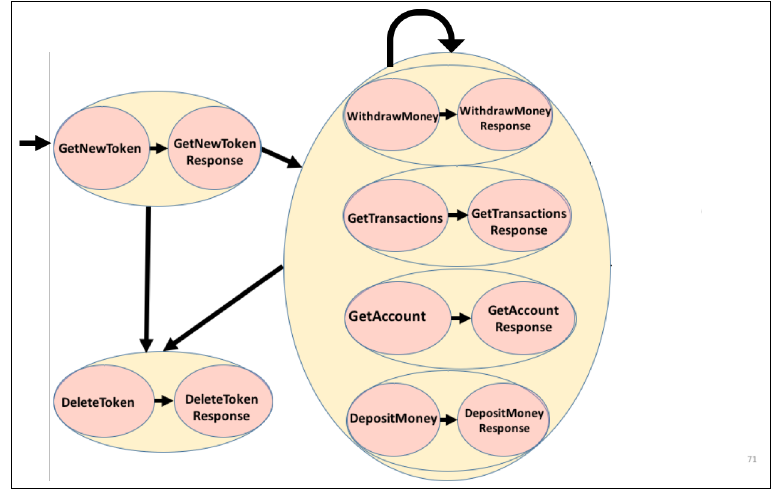
Figure 7. Banking data set control